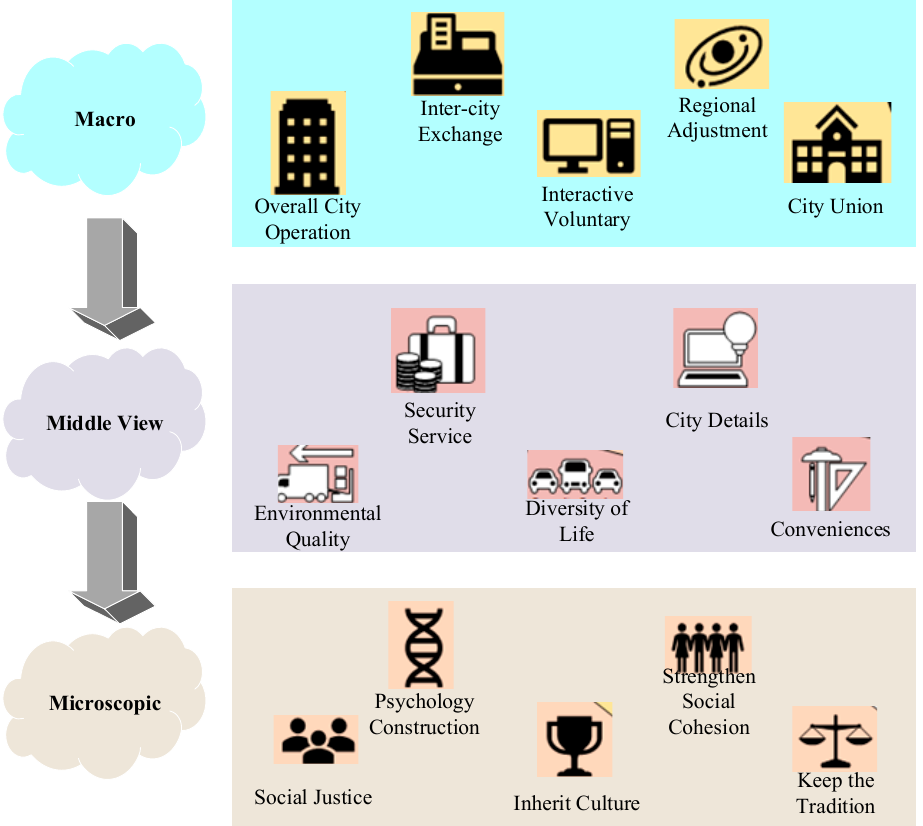
Figure 1. Three important structures of healthy cities.